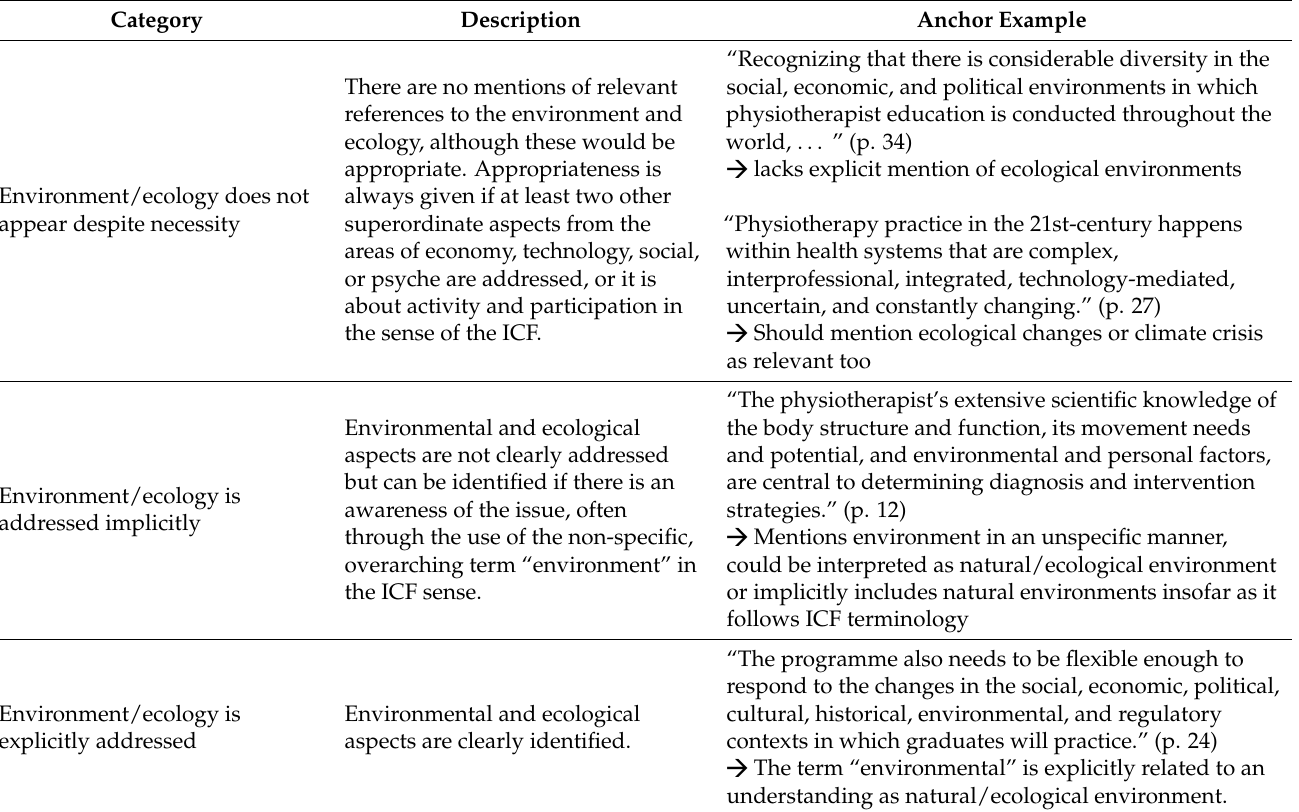
Table 2. Sequence analysis categories, descriptions, and anchoring examples.